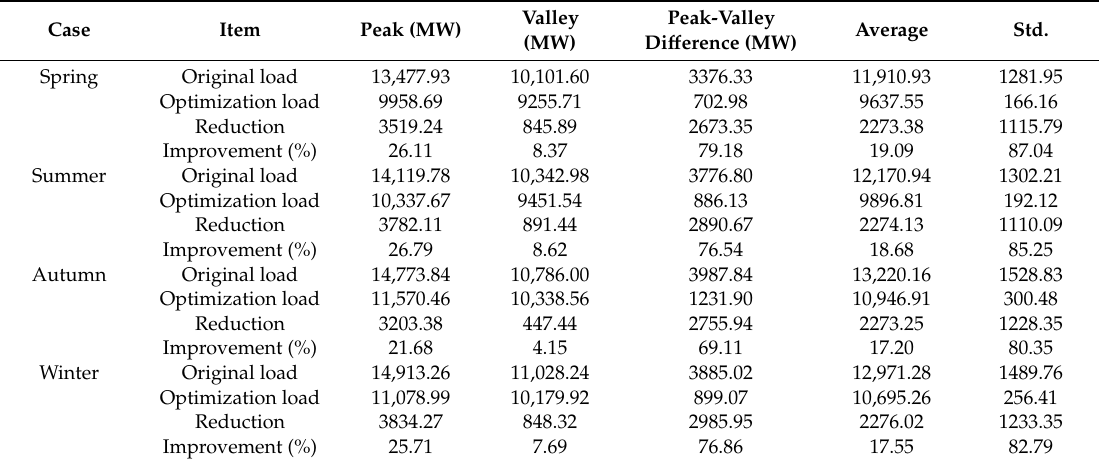
Table 10. Comparison of original load and optimized loads obtained by HSCA in di ff erent seasons. Case Item Std.